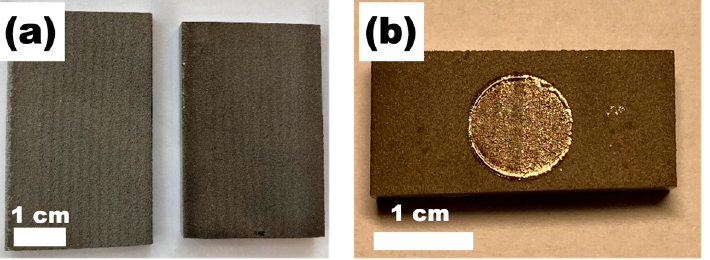
Figure 4. ( a ) Cold-sprayed coatings (Ti on the left and Ti64 on the right-hand side), ( b ) One of the laser surface treated areas.